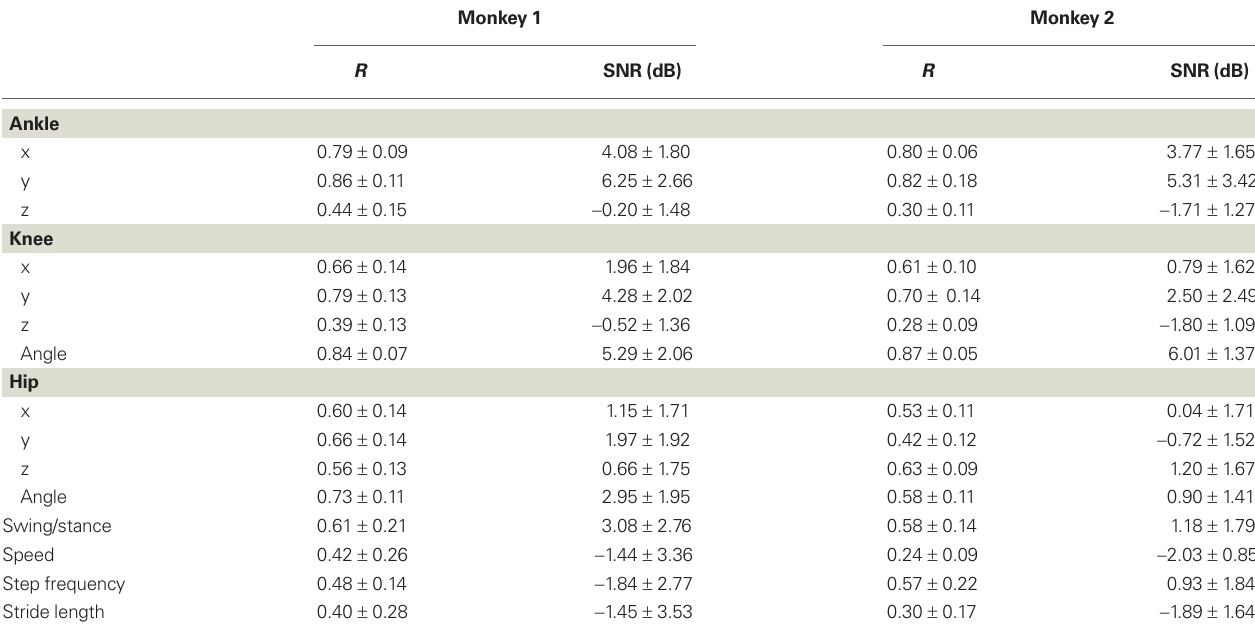
Table 1 | Average prediction accuracy. Correlation coeffi cient and signal to noise ratio (dB) for the predictions of different walking parameters. The numbers represent mean ± standard